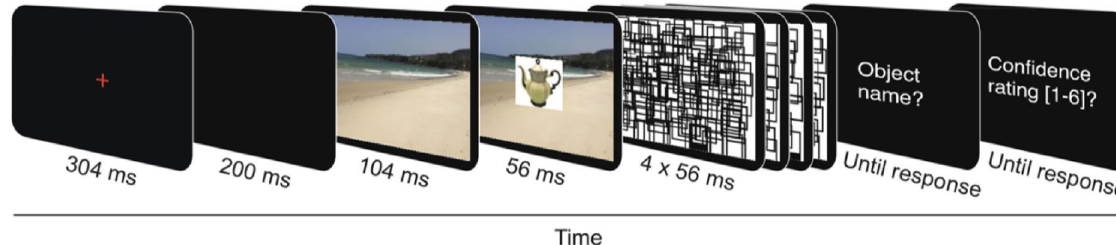
Figure 5. Trial sequence of Experiment 1 (object naming